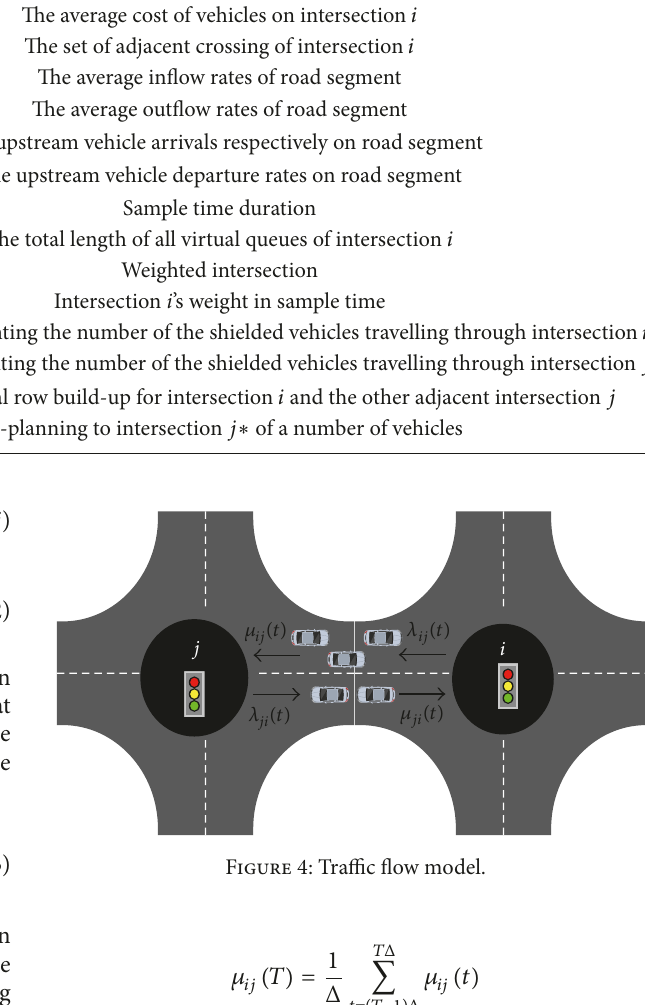
Figure 4: Traffic flow